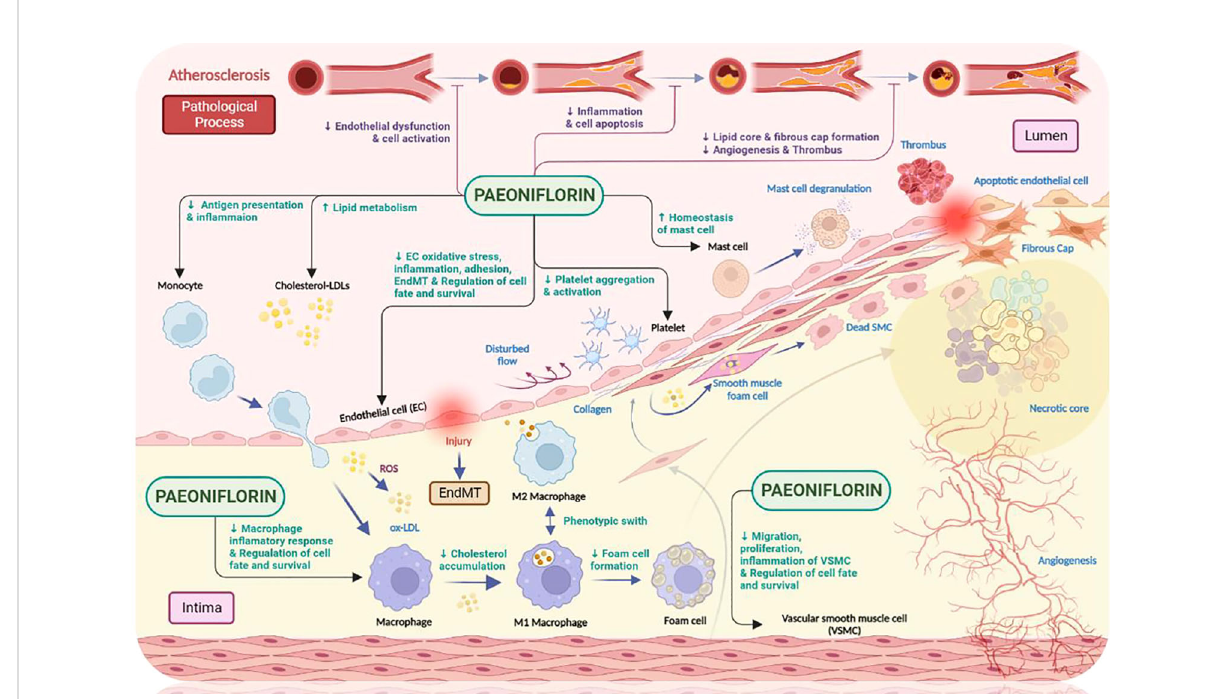
FIGURE 4 The anti-atherosclerotic effects of paeoni fl orin. Paeoni fl orin plays a crucial role in the different stages of atherosclerosis development by affecting different cell types (e.g., monocytes, macrophages, mast cells related to innate immunity; endothelial cells, smooth muscle cells and platelets related to process initiation and progression). Paeoni fl orin can effectively intervene in the development and progression of atherosclerosis by exploiting different signaling pathways. Created in